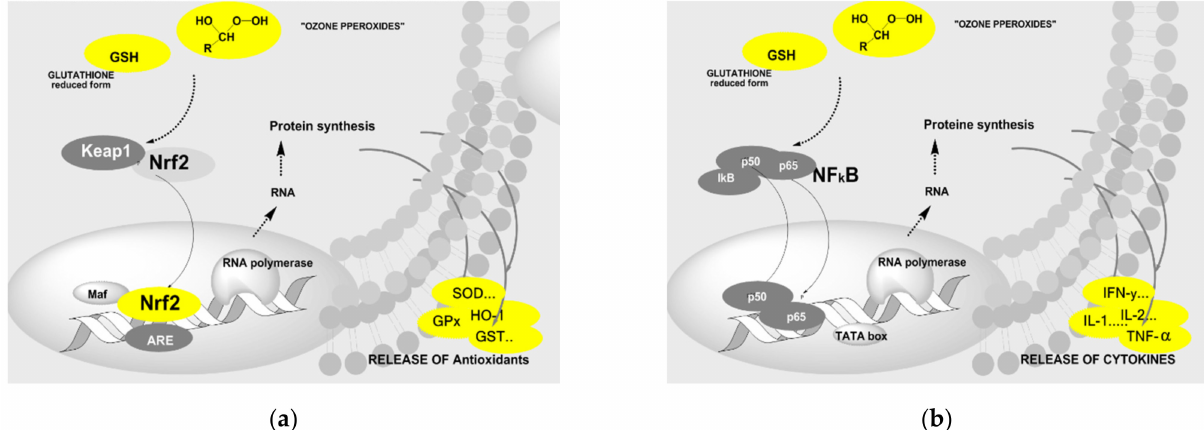
Figure 8. ( a ) The low-dose ozone concept and the regulation of antioxidants, started through the reduction of “ozone- peroxides” by the active (reduced) form of glutathione GSH, initating the signal transduction via the Keap 1/Nrf2–complex and translocation of Nrf2 into the nucleus. In close connection with proteins such as Maf and the ARE complex (antioxidant response elements) the transcription of genes, translation and finally the antioxidant synthesis proceed, see also [15,17,19]. ( b ). Schematic survey of cytokine induction through ozone in mononuclear cells. In healthy organisms, H 2 O 2 acts as a messenger substance in chronic inflammation where the regulation is out of balance. It is most likely to be “ozone peroxide” replacing H 2 O 2 and restarting the regulation acc. to [14,19].